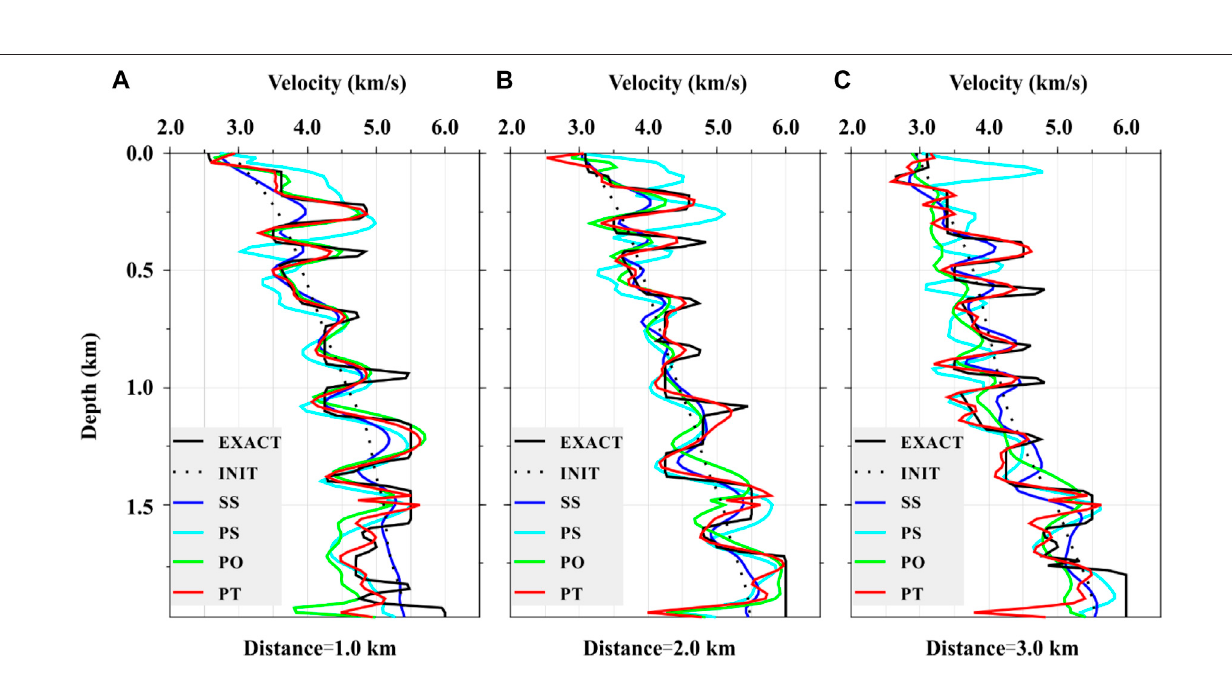
Frontiers in Earth Science |